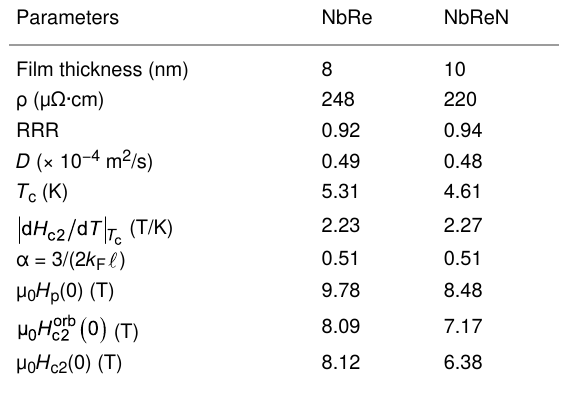
Table 1: Parameter values of NbRe and NbReN microstrips.